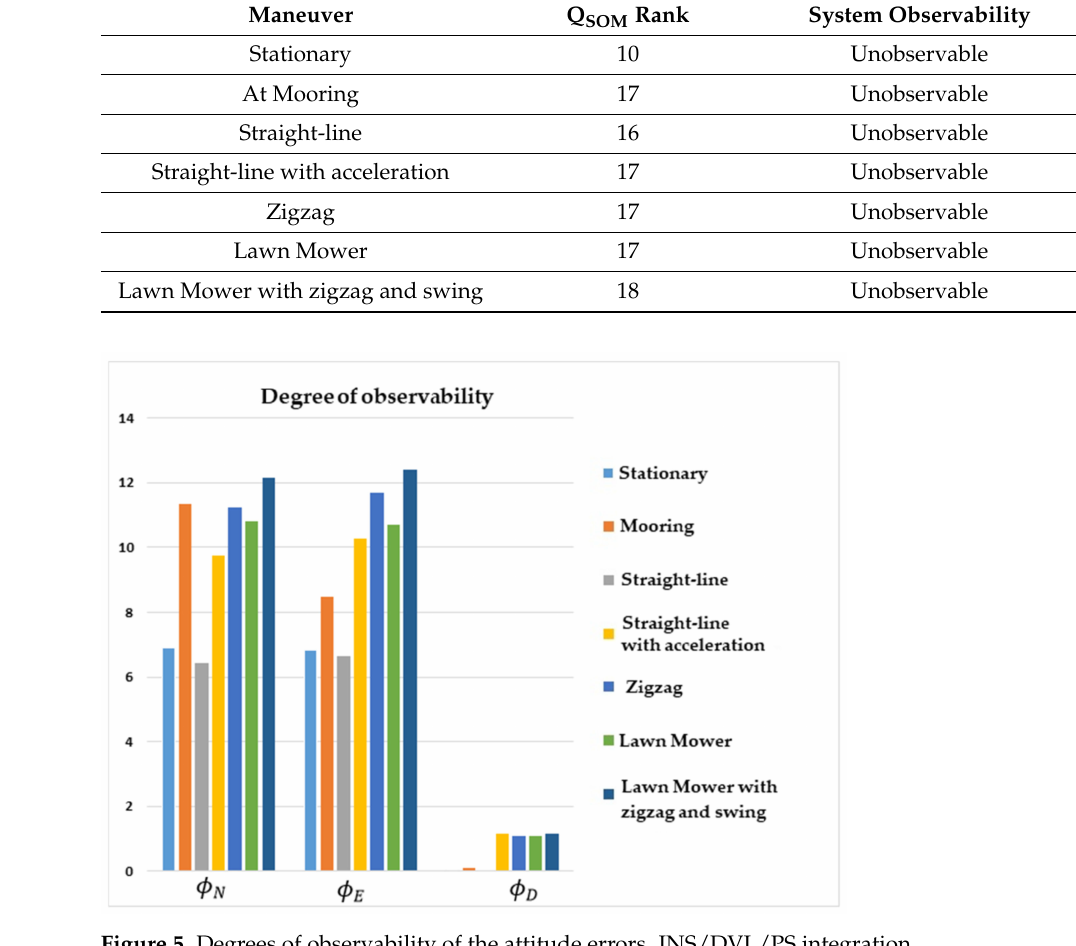
Figure 5. Degrees of observability of the attitude errors. INS/DVL/PS integration.